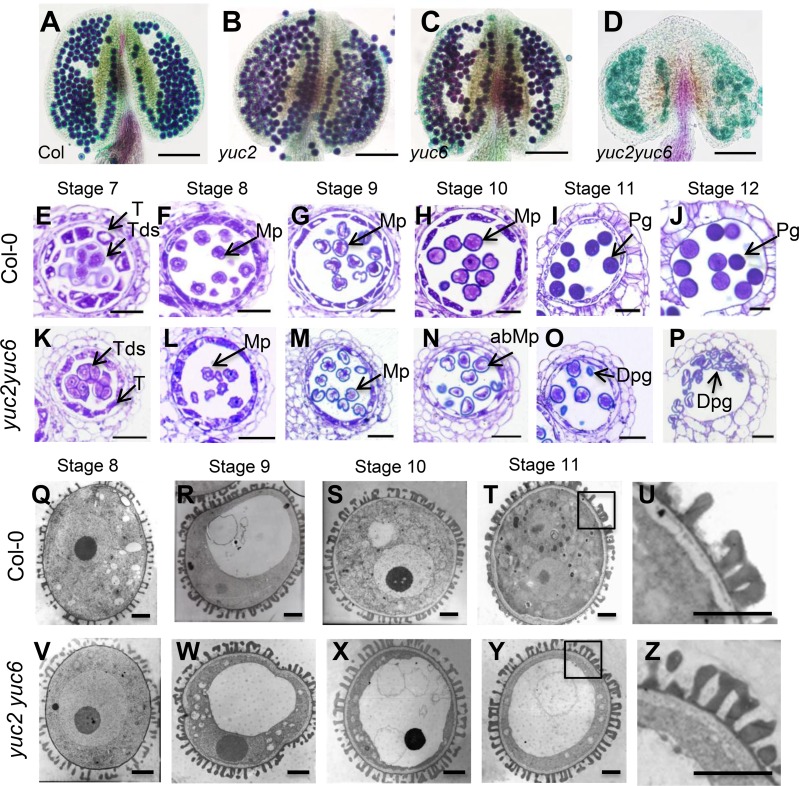
The yuc2yuc6 double mutants were defective in pollen development.(A-D) Alexander staining of anthers of wild type (A), yuc2 (B), yuc6 (C) and yuc2yuc6 (D). Note that yuc2yuc6 lacked viable pollen. (E-P) Semi-thin cross sections of anthers from wild type (E-J) and yuc2yuc6 (K-P) were stained with toluidine blue. Anthers at (E and K) stage 7; (F and L) stage 8; (G and M) stage 9; (H and N) stage 10; (I and O) stage 11; (J and P) stage 12. A microspore or pollen showing reduced or completely invisible of cytoplasm we defined as degeneration state. Note that the degenerated microspores were evident in yuc2yuc6 from stage 10 to 12. (Q-Z) Ultra-structures of pollen grains from wild type (Q-U) and yuc2yuc6 (V-Z) plants. Microspores from anthers at stage 8 (Q and V); stage 9 (R and W); stage 10 (S and X); stage 11 (T and Y) were shown. Enlarged images from T and Y were shown in (U and Z). It is clear that the pollen wall pattern in yuc2yuc6 appears similar to that in WT. Most of the cytoplasm is degenerated in the microspore from stage 10 and 11 anthers of yuc2yuc6 (X and Y). T, Tapetum; Tds, tetrads; Mp, microspore; abMp, abnormal microspore; Pg, pollen grain; Dpg, degenerated pollen grain. Bars = 100μm (A-D), 20 μm (E-P), 1 μm (Q-Z).